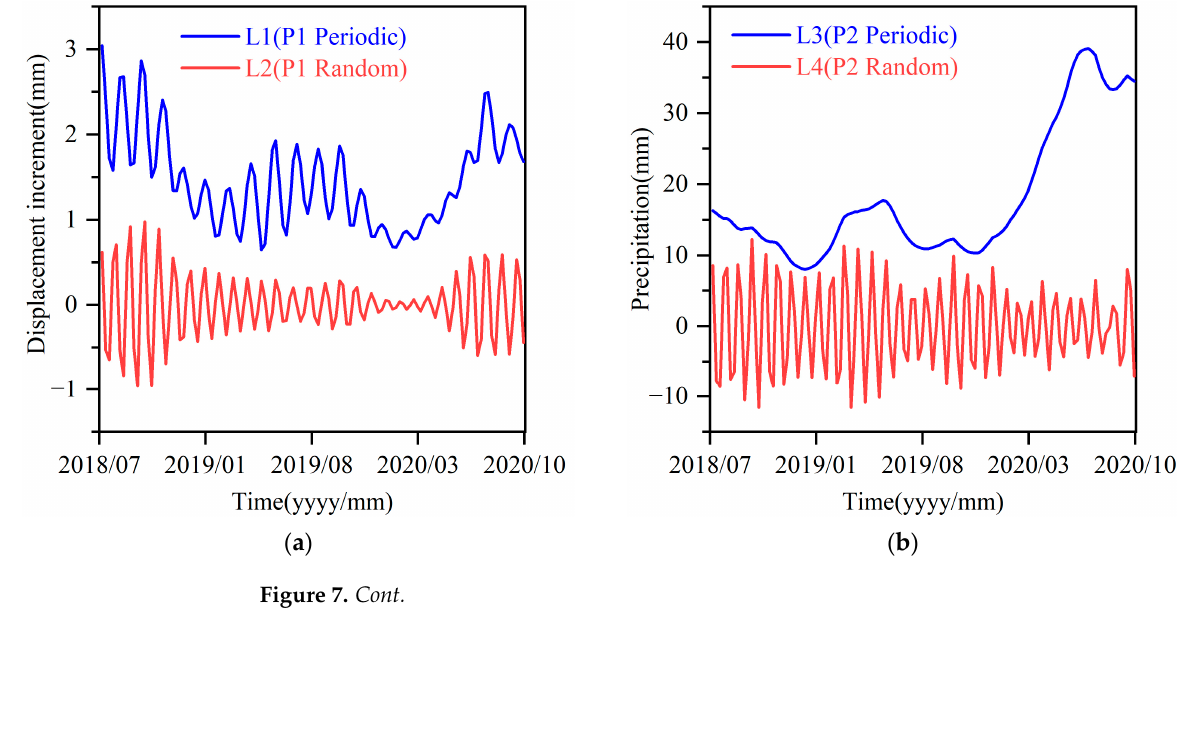
( d ) Figure 7. Decomposition results of the influencing factors: ( a ) decomposition result of P1; ( b ) de- composition result of P2; ( c ) decomposition result of P3; ( d ) decomposition result of P4. 4.1.3. Relational Analysis of Displacement Components and Influencing Factor Compo- nents In order to verify the rationality of the influencing factor selection after decompos- ing the displacement data and the influencing factor data, it was necessary to analyze the correlation between the displacement data components and the influencing factor components. Gray relational degree theory is an evaluation method in gray system theo- ry [48]. It can compare the relational degrees between different sequences and is suitable for studying the problems of insufficient data, poor information, and uncertainty [49]. The gray relational degree model holds that, when the resolution coefficient ρ is 0.5, the closer the value of the correlation degree r is to 1, and the better the correlation is